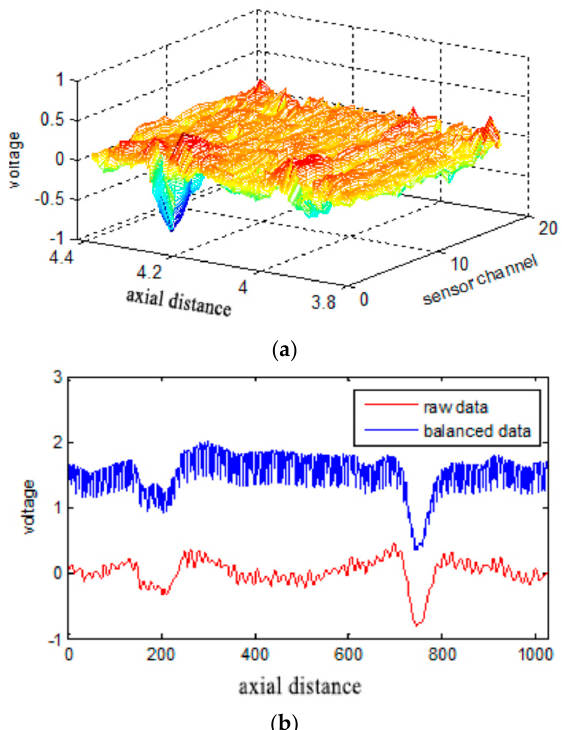
Figure 7. ( a ) The surface chart of the balanced data (the raw data appear in Figure 5b; ( b ) Comparison of a single channel of raw data with the balanced data (the balanced data is obtained from Figure 7a and the raw data from Figure